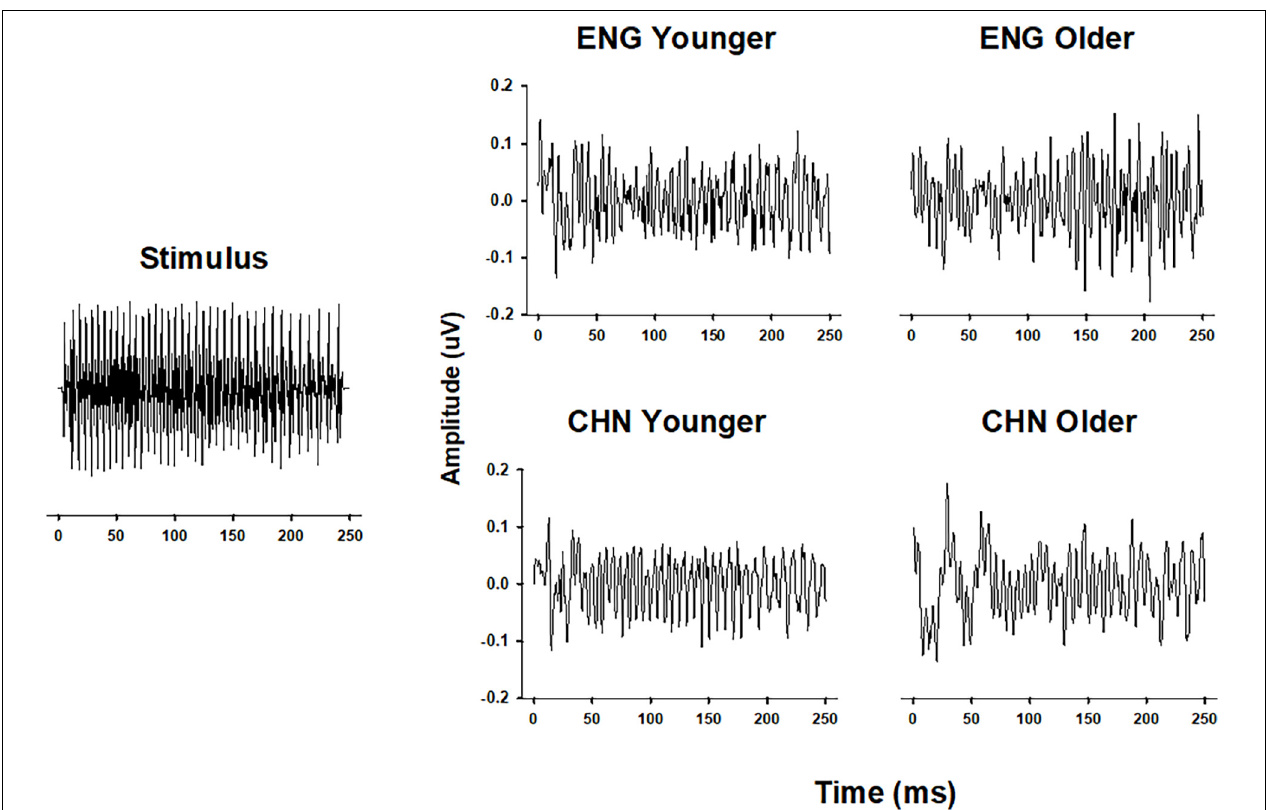
FIGURE 1 | Comparison of FFR waveforms in different groups. Temporal waveforms of the original stimulus/yi4/( left panel ) and of the grand-average FFR of all four groups ( right panel ). FFR waveforms were plotted as Amplitude (in µ V) as a function of Time (in ms). ENY, English younger; ENO, English older; CHY, Chinese younger; CHO, Chinese